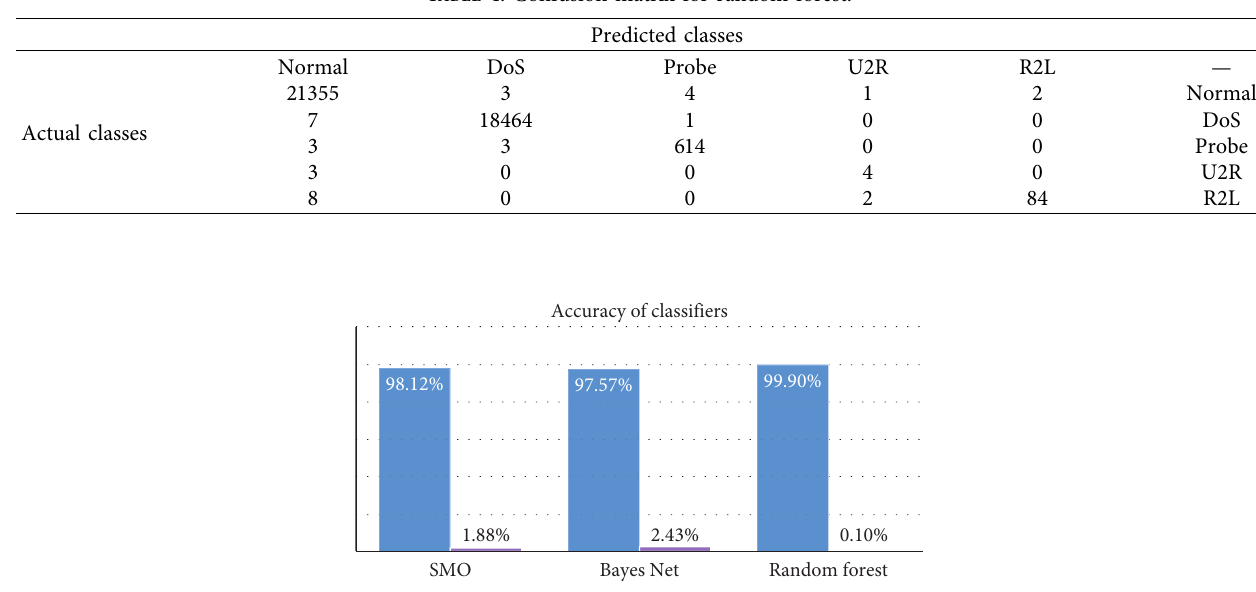
Table 4: Confusion matrix for random forest.